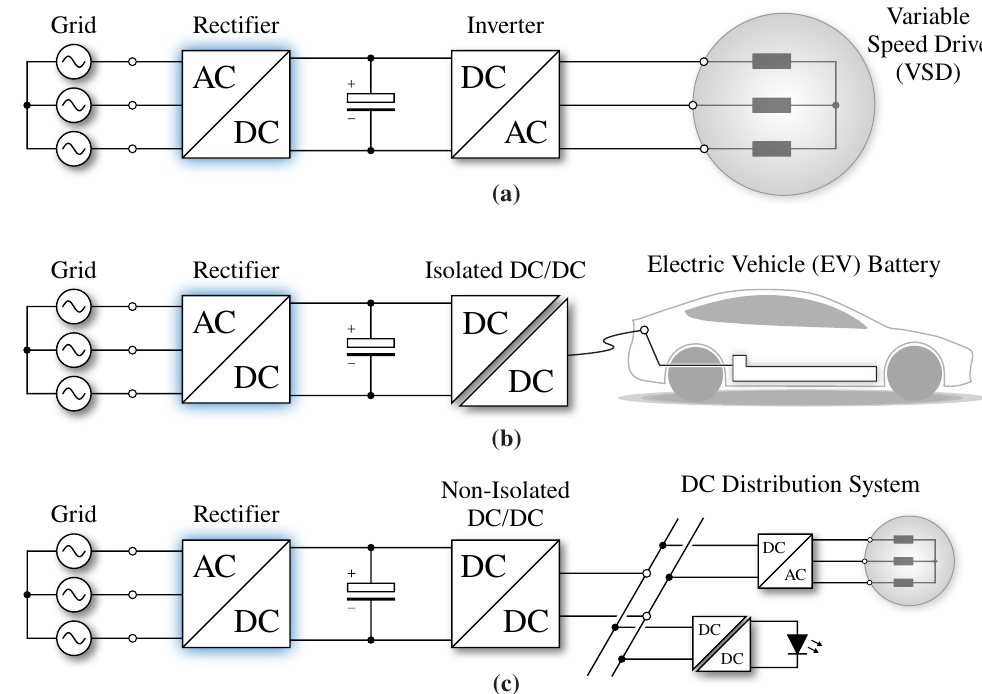
Figure 1. Schematic overview of typical grid-connected three-phase rectifier configurations sup- plying electrical loads such as ( a ) three-phase DC/AC inverters for variable-speed drives (VSDs) or uninterruptible power supplies (UPSs), ( b ) isolated DC/DC converters for electric vehicle DC fast charging, telecommunication and data center power supplies, lighting systems or induction heating, and ( c ) non-isolated DC/DC converters for DC distribution systems, high-power DC loads or DC